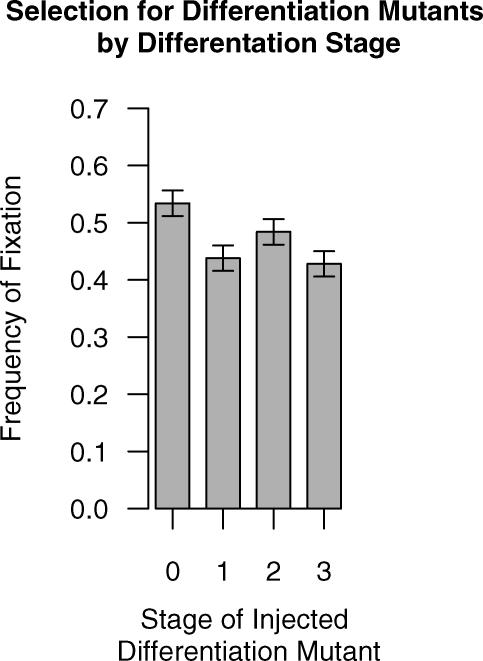
Frequency of Fixation of a Differentiation Knockout Mutant as a Function of TimeThe model was run for 500 timesteps to allow the cell populations to equilibrate before a mutant cell that could not differentiate was injected. Those mutant clones that did not go extinct in the next 100 timesteps expanded rapidly. Mutants injected into the stem cell compartment reached fixation more frequently than mutants injected into a TAC compartment. Each data point represents 500 trials with standard error bars.